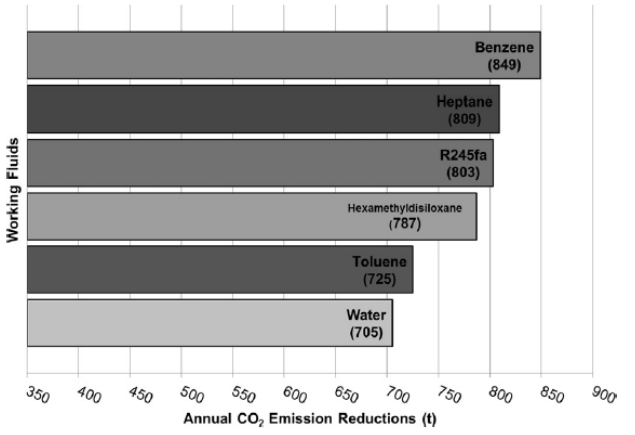
Figure 21. Annual CO 2 Emission Reductions for different WHR working fuels. Reprinted with permission from ref. [102]. Copyright © 2016 Elsevier Ltd. All rights reserved.